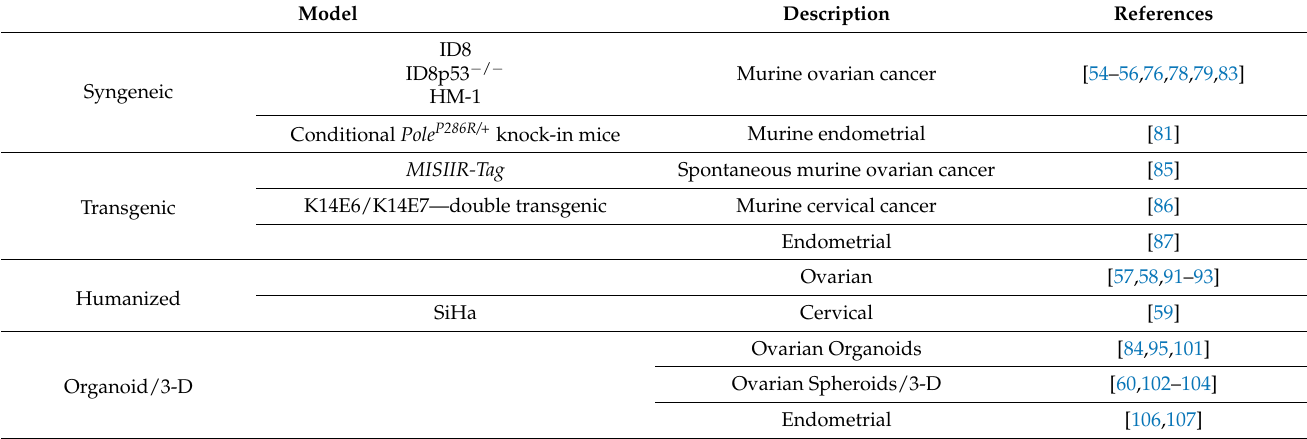
Table 2. Summary of preclinical models used in gynecologic oncology